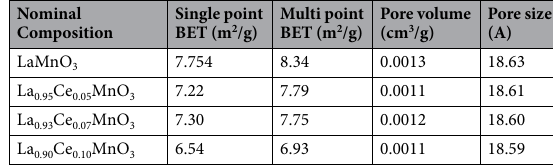
Table 1. Textural properties of the Ce doped catalysts (La 1 − x Ce x MnO 3